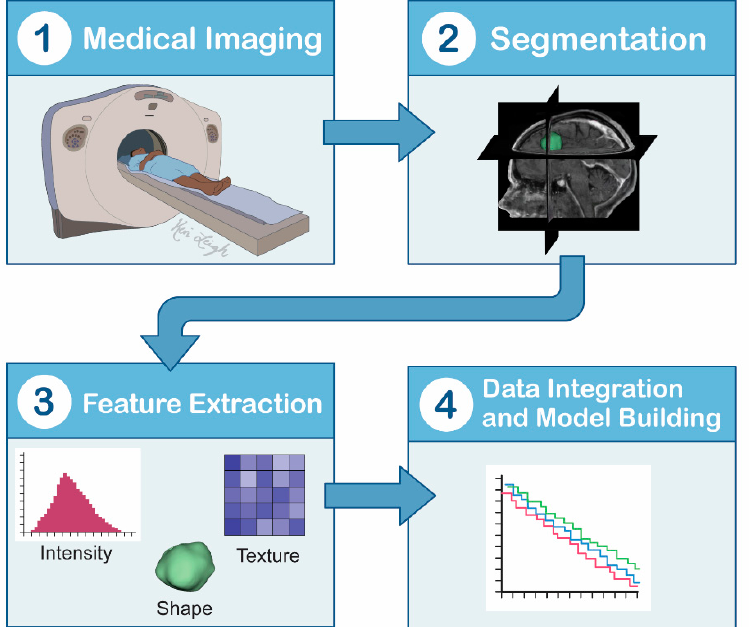
Figure 7. Radiomics and machine flow learning. (1) A medical image is generated using any one of the advanced imaging modalities or multiple, different modalities. (2,3) Segmentation of the imaging is performed while also extracting feature data, such as intensity, texture, and shape. (4) This allows radiologists to build programs and algorithms to increase the sensitivity of imaging by creating systems that utilize support vector machines and multilayer perceptrons.